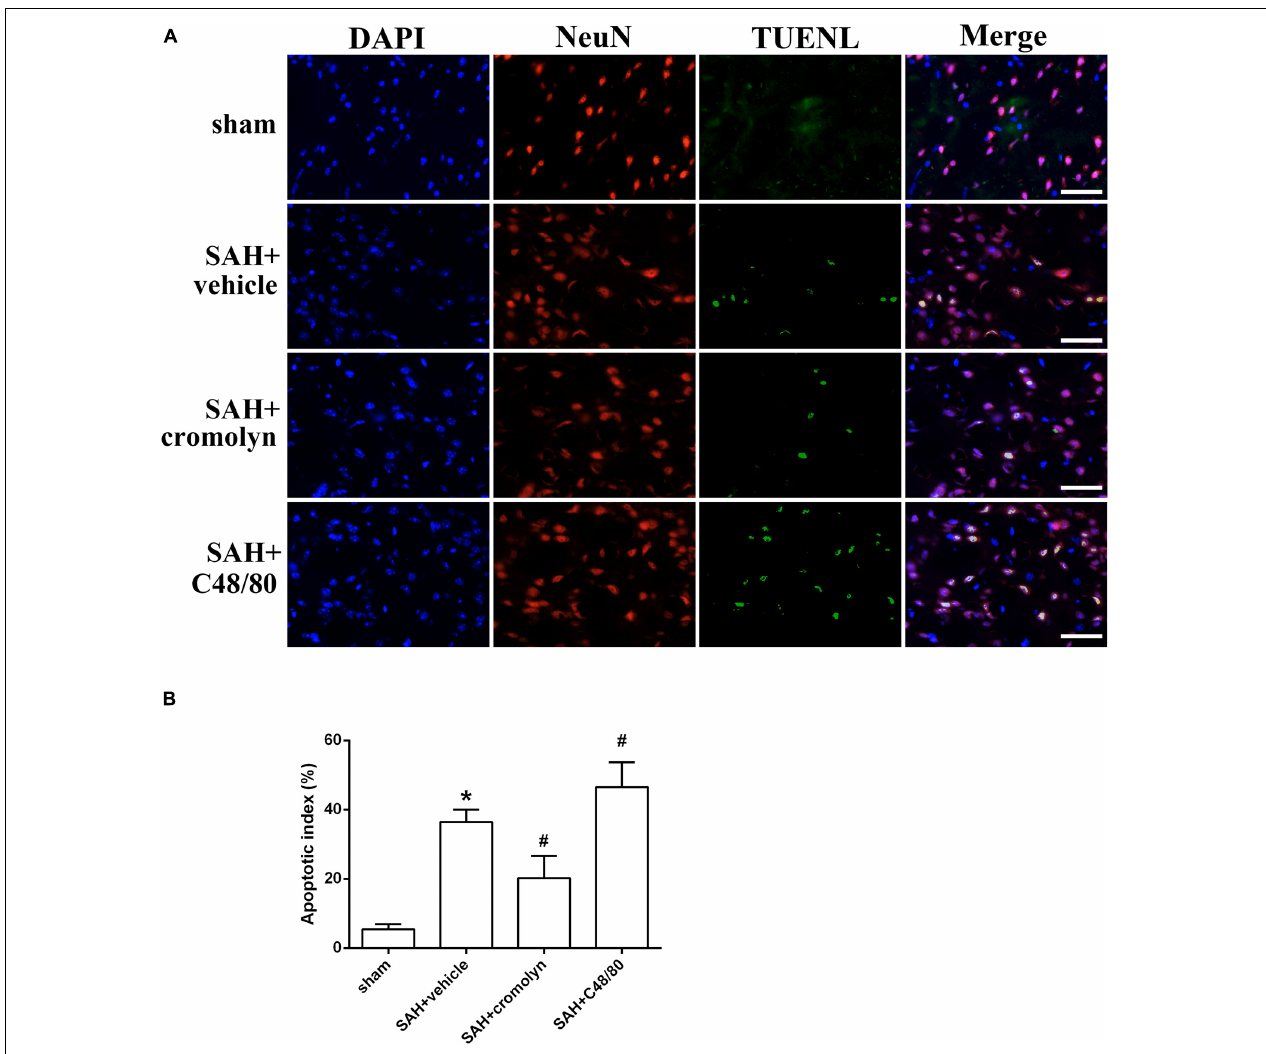
FIGURE 5 | Effect of MCs on SAH-induced neuronal injury. (A) Representative microphotographs showing the co-localization of TUNEL positive cells (green) with NeuN (red) in cortex. (B) The quantitative analysis of TUNEL-positive neurons. Scale bar = 50 µ m. n = 6. Data are represented as mean ± SD. * P < 0.05 versus sham group. # P < 0.05 versus SAH + vehicle